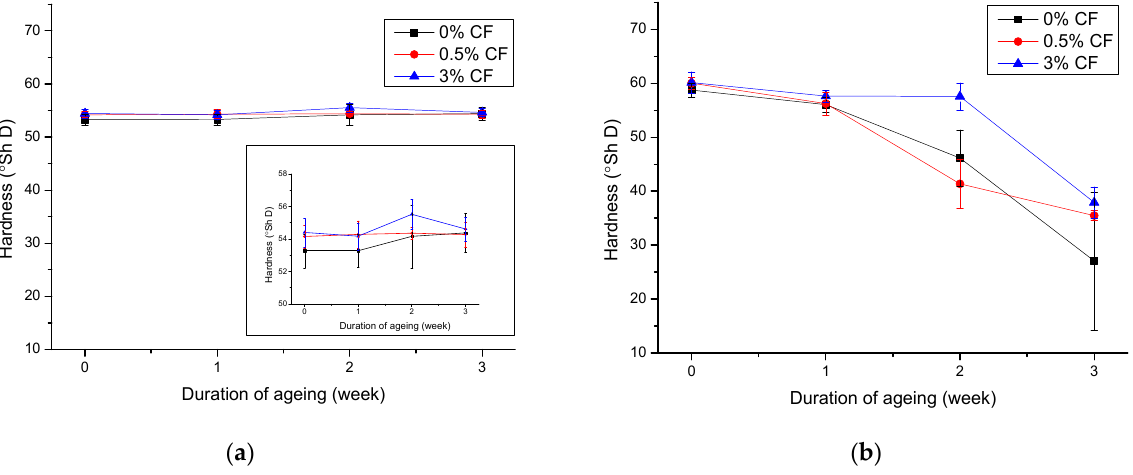
Figure 8. Hardness of aged PCL/PCL/CF blends: ( a ) 100/0/0, 100/0/0.5, 100/0/3.0 and ( b ) 70/30/0, 70/30/0.5, 70/30/3.0.